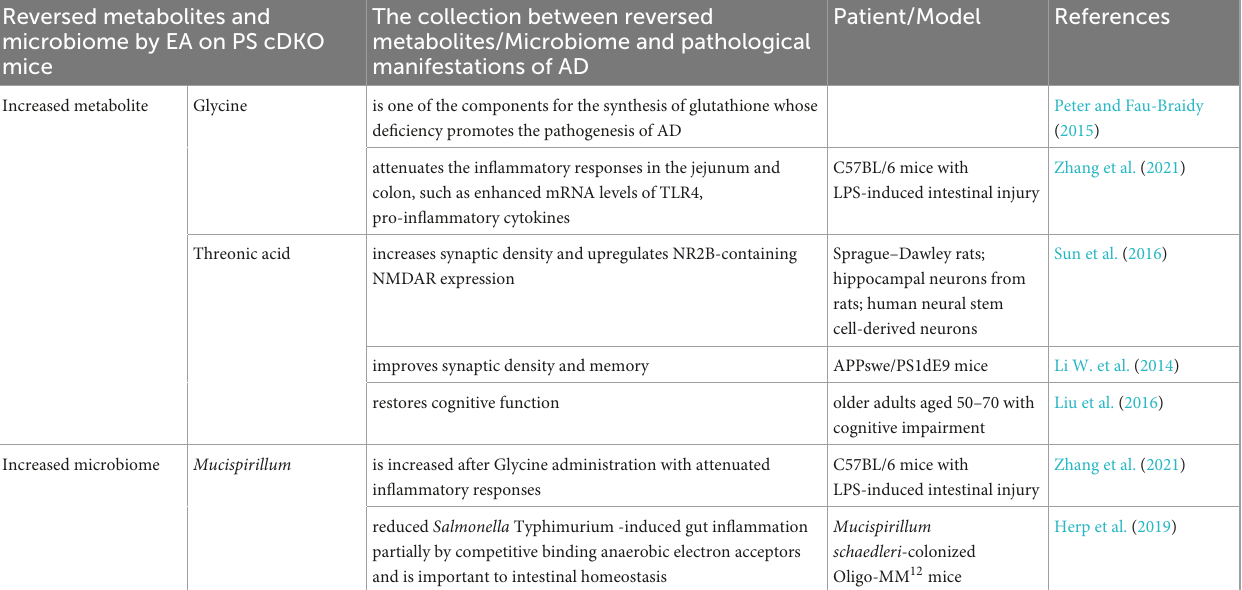
TABLE 1 Reversed metabolites and microbiome by electroacupuncture on PS cDKO mice and their collection with pathological manifestations of AD. Reversed metabolites and The collection between reversed microbiome by EA on PS cDKO metabolites/Microbiome and mice